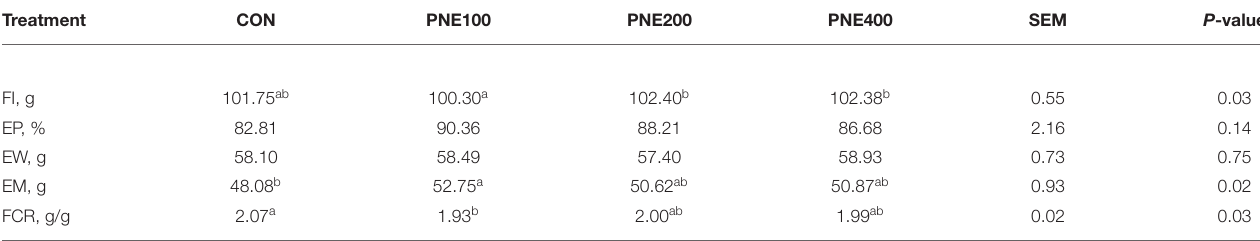
TABLE 2 | Effect of dietary pine needle extract (PNE) supplementation on production performance of laying hens 1 ( n = 15). Treatment